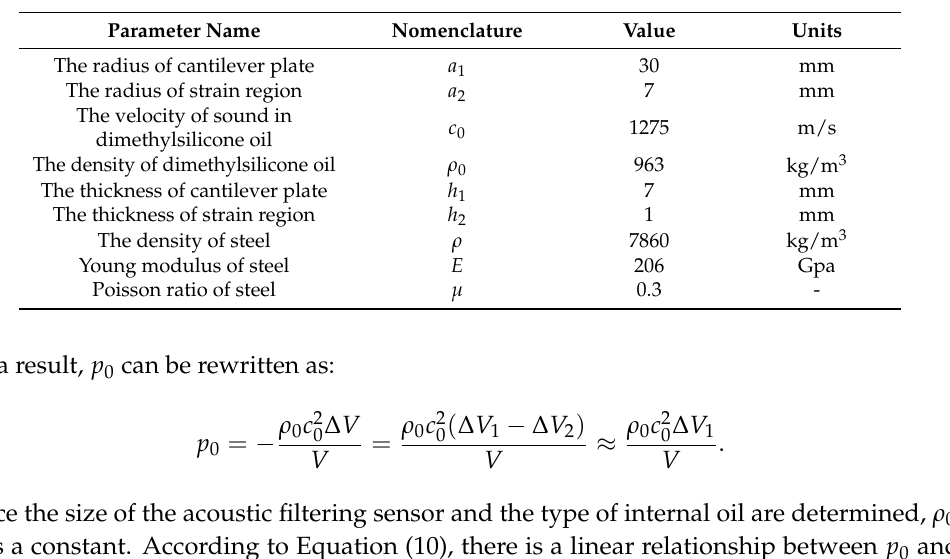
Table 1. The structure parameters of the